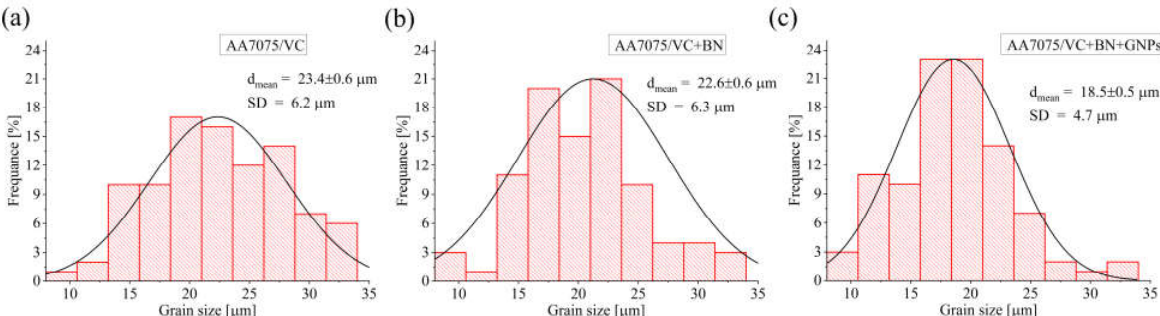
Figure 3. Grain size distributions of the manufactured composites reinforced with (a) mono-rein- forcement (VC), (b) hybrid-reinforcements (VC + BN), and (c) triple-reinforcements (VC + BN + GNPs).